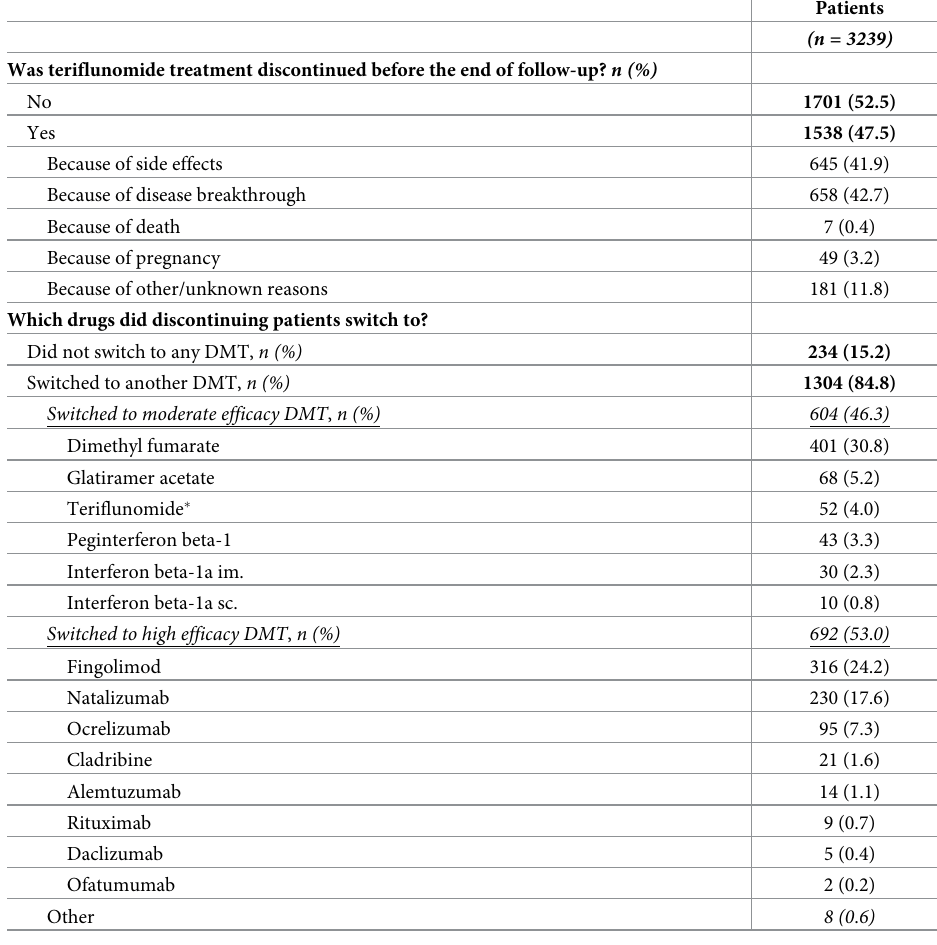
Table 4. Teriflunomide discontinuations and treatment switches during the study period (2013–2019).